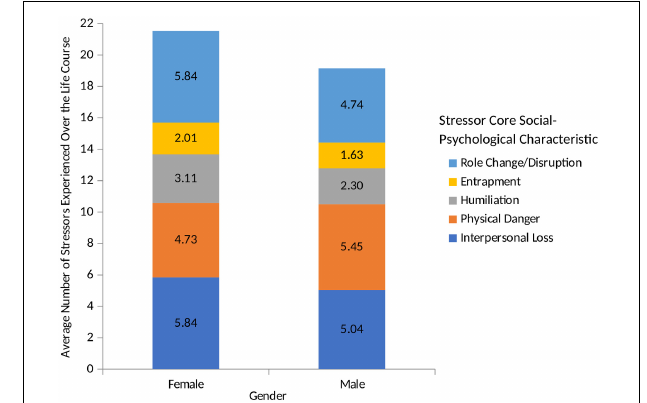
FIGURE 2 | Lifetime stressor exposure by stressor count for males and females. Examining participants’ lifetime stress exposure by gender revealed that with respect to primary life domain, women experienced more reproduction stressors, other relationship stressors, and deaths than men. In contrast, men experienced more life-threatening stressors than women.